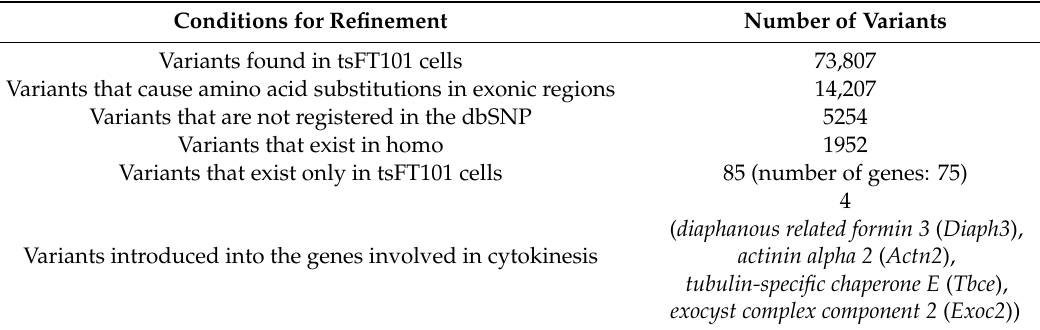
Table 1. Exome analysis of tsFT101